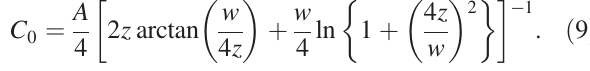
9 eV. (c) The normalized charge p ¼